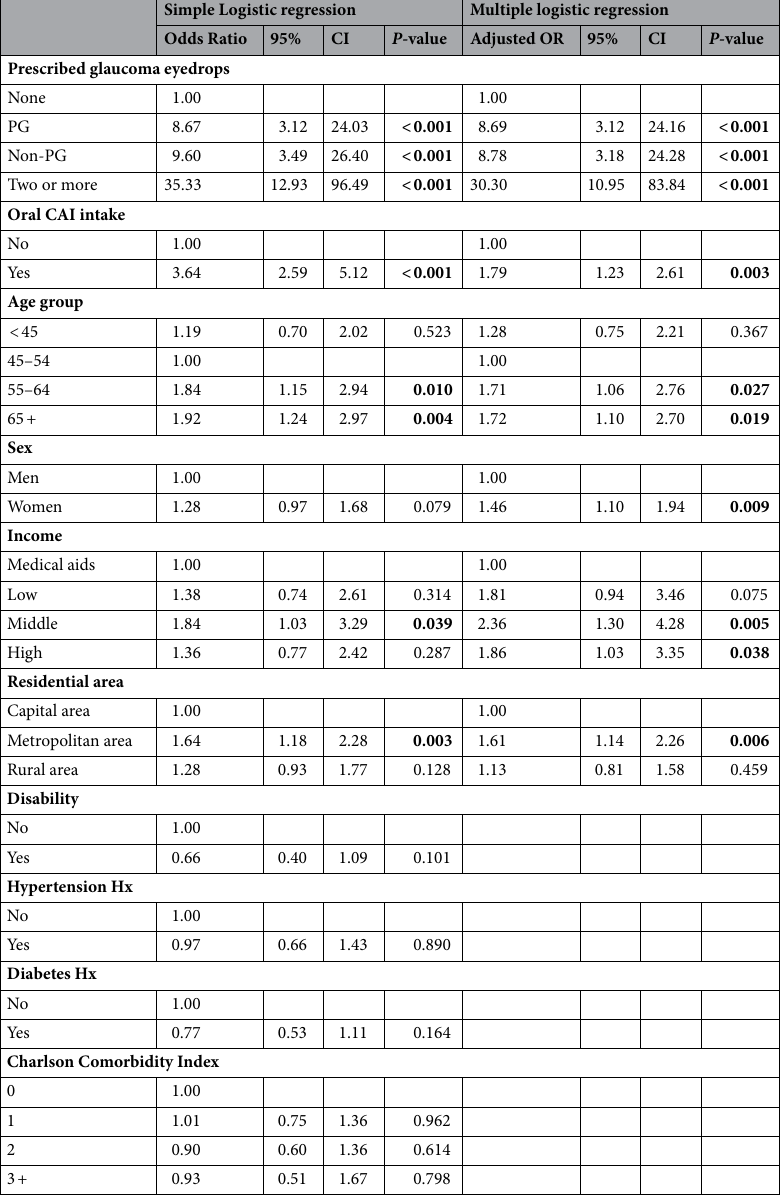
Table 2. Results of multiple logistic regression. CI: confidence interval; OR: odds ratio; PG: Prostaglandin analogue; CAI: Carbonic anhydrase inhibitor; Hx: History, * P -values were calculated using logistic regression. Indicated in bold type, P < 0.05 indicates statistical